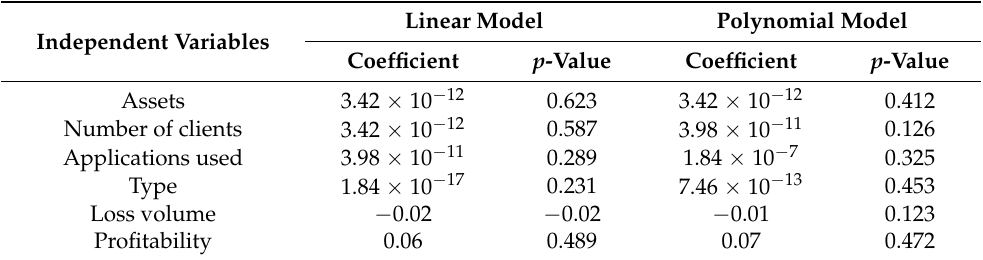
Table 4. Regression analysis between assets (dependent variable) and clients’ dynamics (independent variable) in Russian brokers and banks with mobile apps.